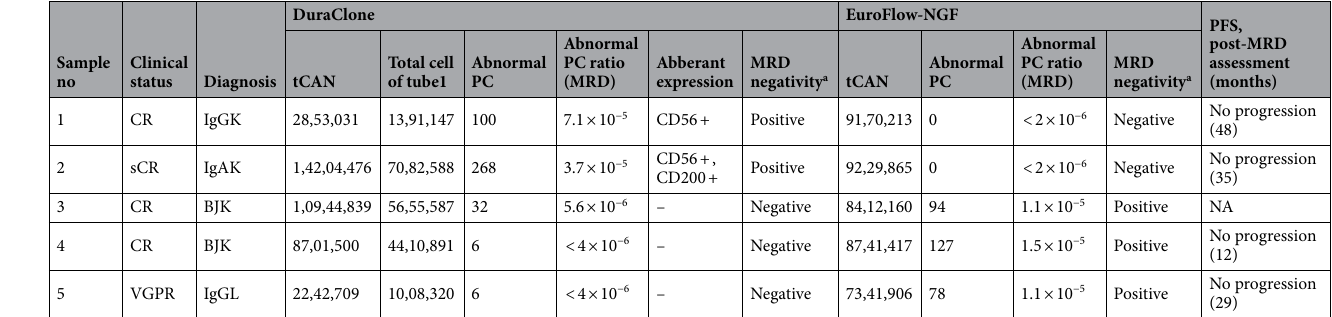
(Fig. 4D). Conversely, in the qualitative study of MRD detection, 5 samples (5.2%) showed a disagreement of MRD negativity when a cutoff value of 10 −5 was applied (Fig. 4E, Table 2). Among these samples, three were found to be MRD positive by EuroFlow-NGF and MRD negative by DuraClone, and the total number of cells acquired by EuroFlow-NGF (median 8.4 × 10 6 , range 7.3 × 10 6 –8.7 × 10 6 ) was almost the same with that acquired by the DuraClone panel except for sample No. 5 (median 8.7 × 10 6 , range 2.2 × 10 6 –10.0 × 10 6 ; p = 0.7). In contrast, two samples were found to be MRD negative by EuroFlow-NGF and MRD positive by DuraClone, judged as such using the following antigens: 1 sample by CD56 only and 1 sample by CD56 and CD200 (Fig. 4E and Table 2).